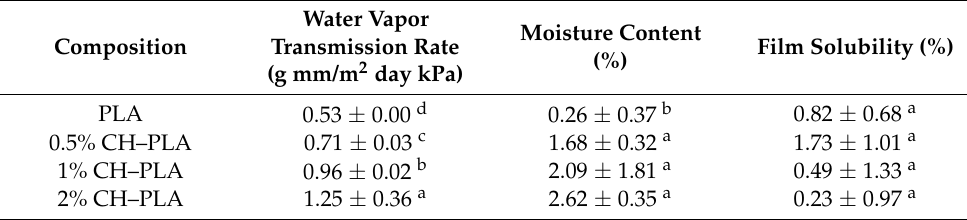
Table 2. Water vapor transmission rate, moisture content, and film solubility of PLA and Chitosan– PLA